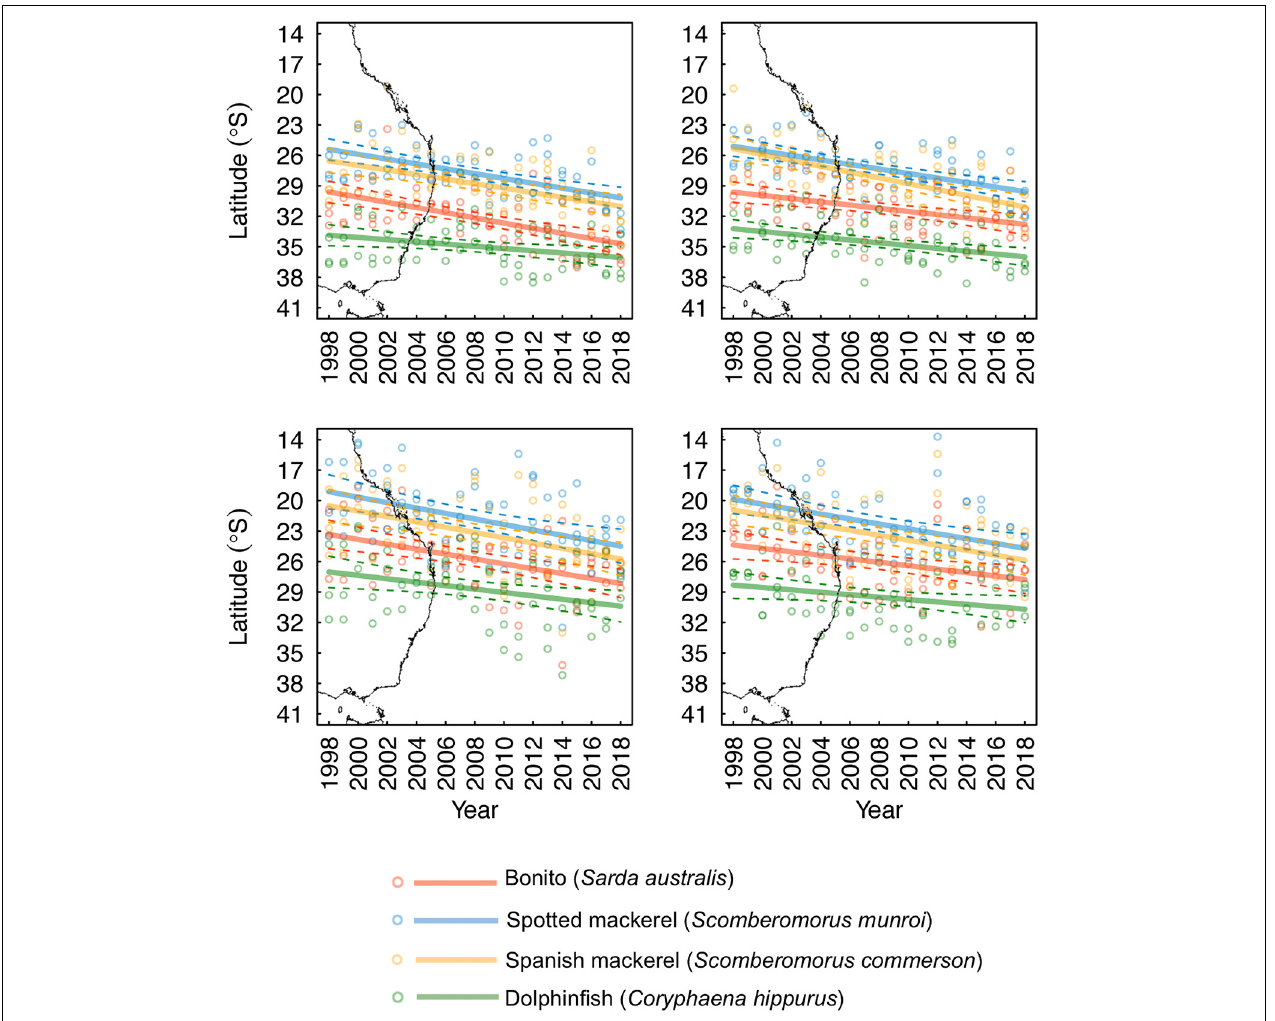
FIGURE 5 | Seasonally explicit latitudinal trends in monthly predictions of the poleward edge of species’ core oceanographic habitats nearshore of the continental shelf-break (dashed lines denote 95% confidence intervals). The east Australian coastline has been underlaid to aid visual interpretation of the trends presented.